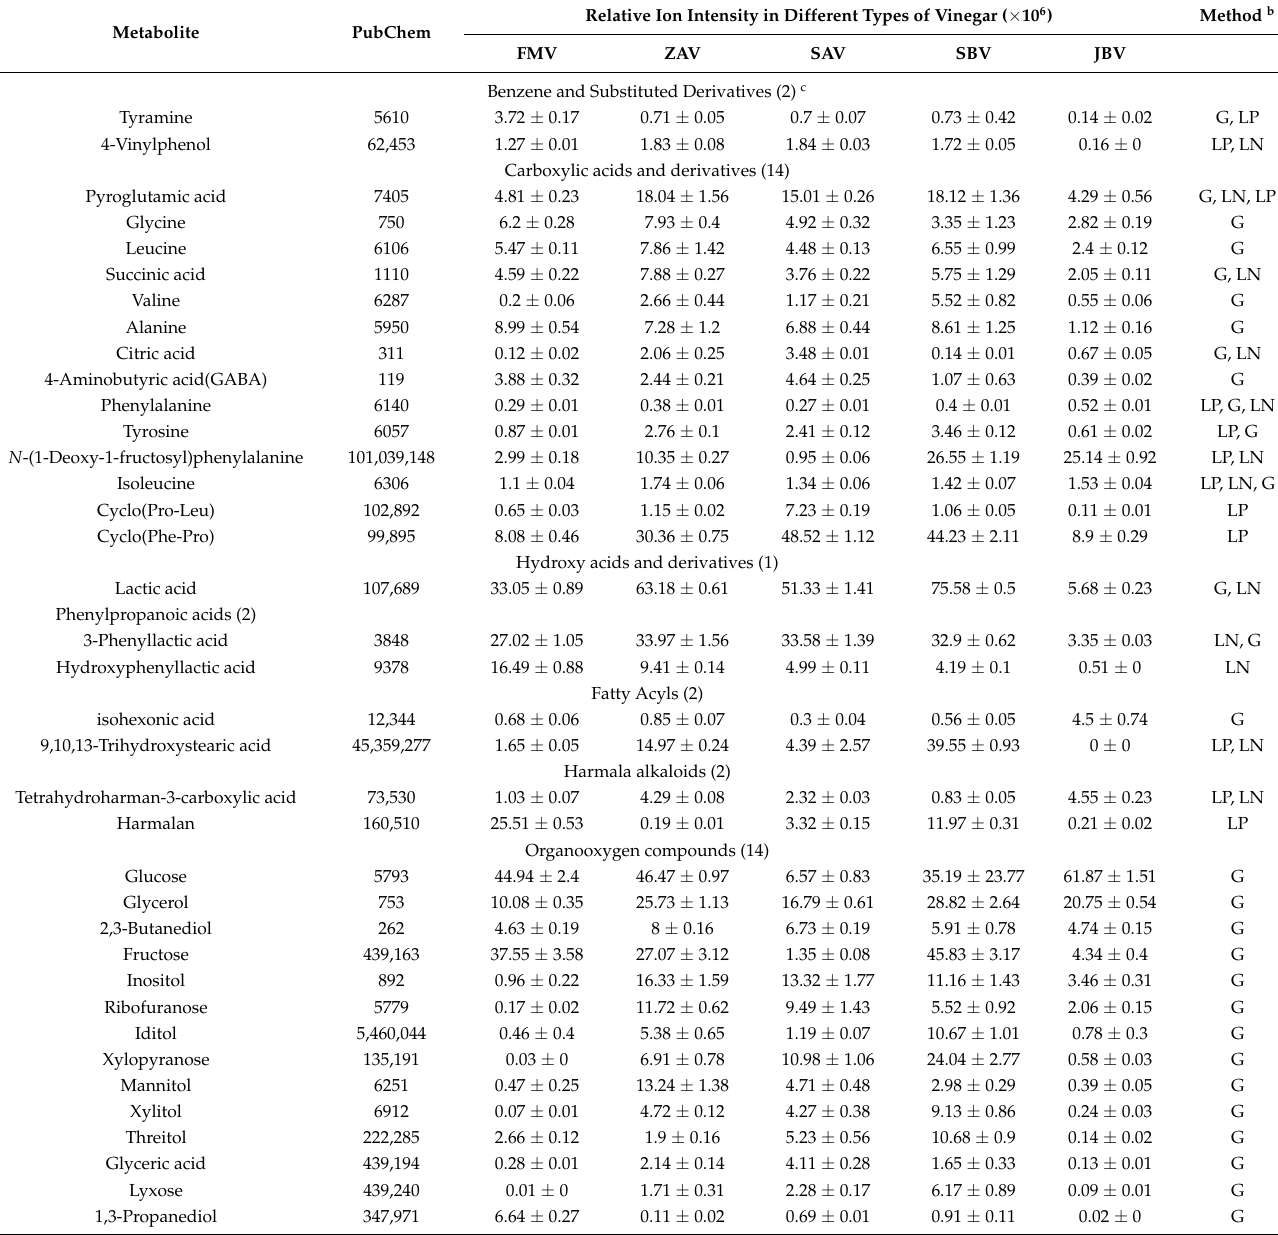
Table 1. High-intensity metabolites identified by GC-MS and label-free UHPLC-QTOF-MS a .